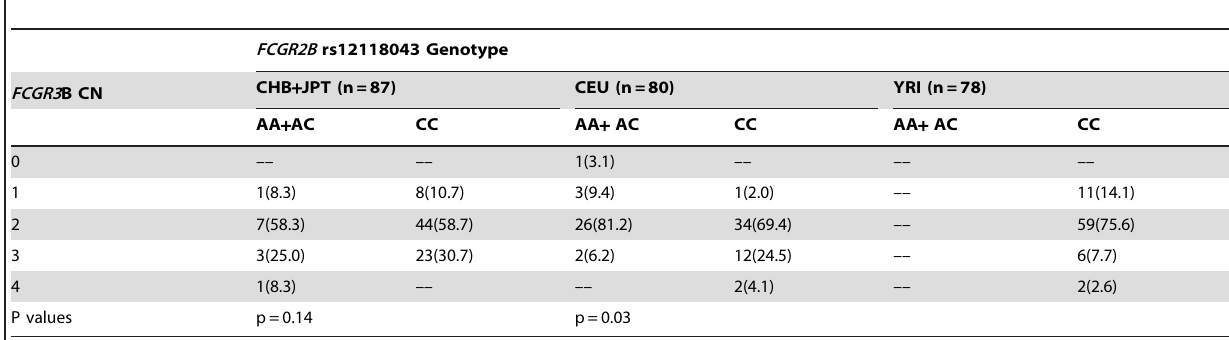
Table 2. Associations between FCGR3B copy numbers and FCGR2B rs12118043 genotypes in HapMap samples.